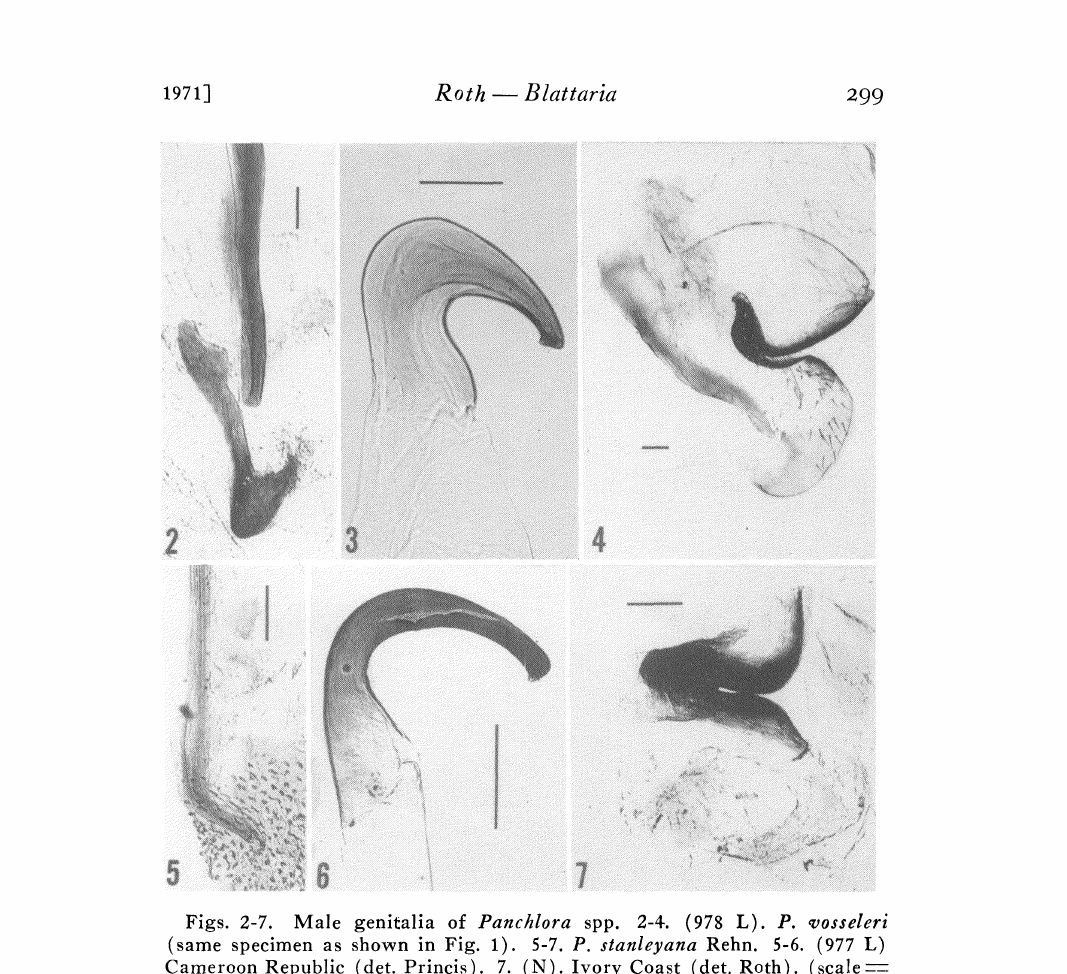
Figs. 2-7. Male geniealia of Panchlora spp. 2-4. (978 L). P. eosseleri (same specimen as shown in Fig. 1). 5-7. P. stanleyana Rehn. 5-6. (977 L) CameroonRepublie (det. Prineis). 7. (N). Ivory Coast (det. Roth). (scale-- 0.1